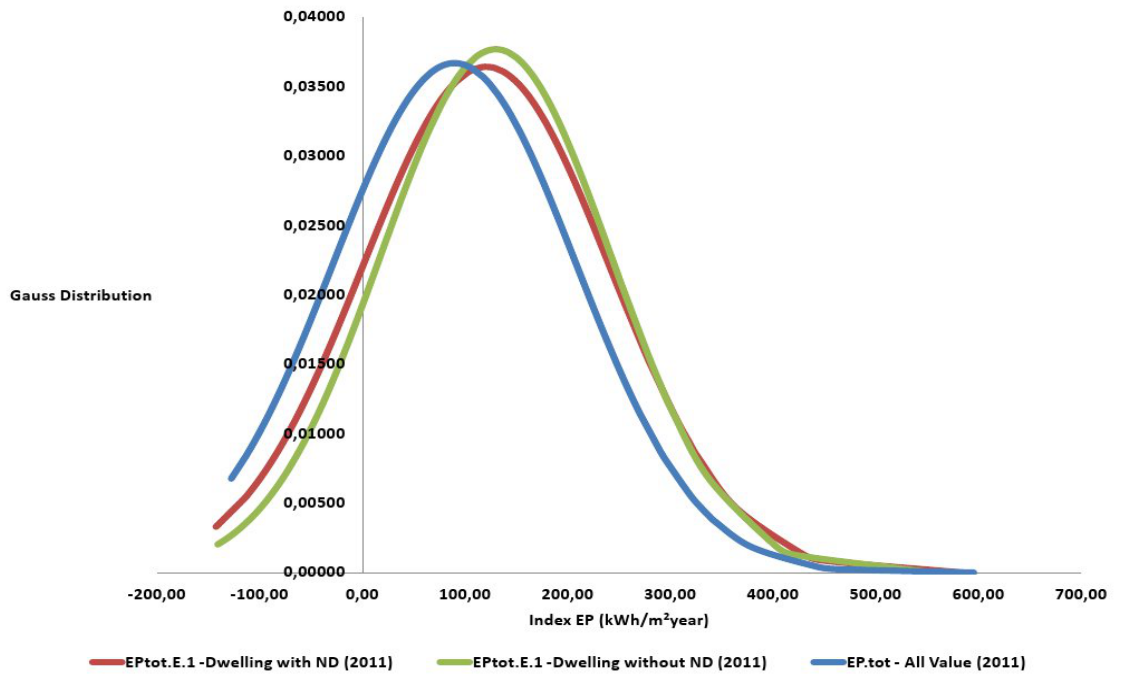
Figure 4. Indexes EP 2010 and 2011 comparison of Gaussian